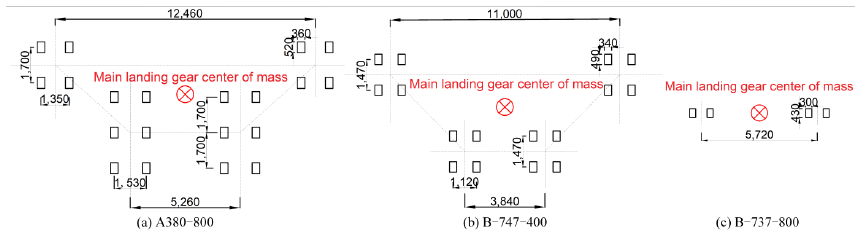
Figure 3. The main landing gear configuration.